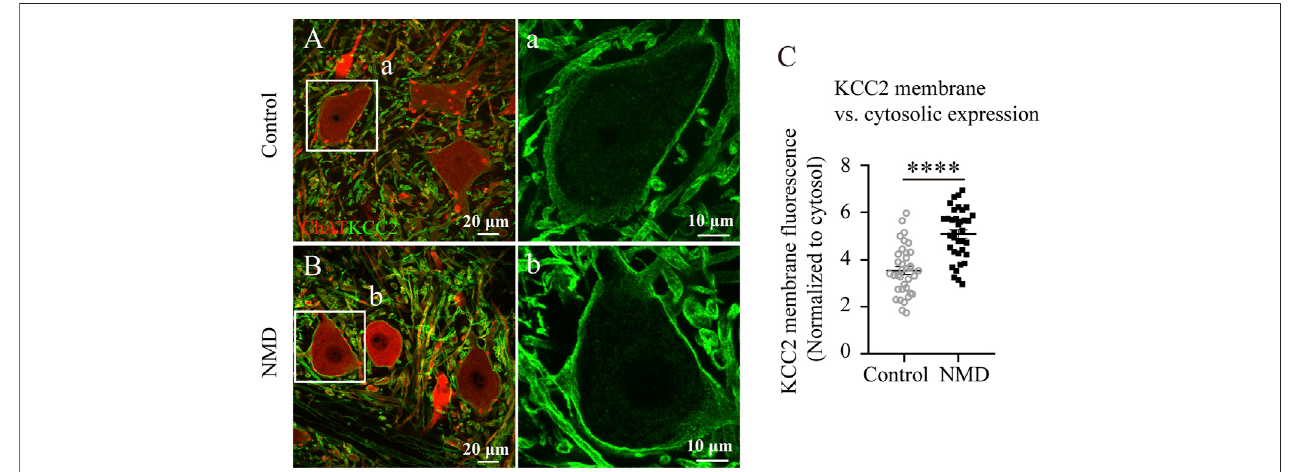
FIGURE 7 | Membrane expression of KCC2 on lumbar motor neurons in NMD-treated group is higher than in injured controls. (A – B) Representative images showingChAT(red)andKCC2(green)immunolabelinginlumbarmotoneuronsofcontrol (A) orNMD-treatedrats (B) .Theboxedregionineachimageismagni fi edinthe correspondingpanela,btoshowKCC2immunolabeling. (C) MeanpixelintensitiesofKCC2motoneuronalmembraneimmuno fl uorescencenormalizedtoadetermined area of the cytosol. The membrane-cytosol KCC2 ratio was signi fi cantly larger in NMD-treated rats than in controls (circles or squares represent individual motoneurons; all groups contained six animals per group, and six motor neurons were analyzed per animal). Unpaired t-test, t (70) (cid:1) 6.188, p <